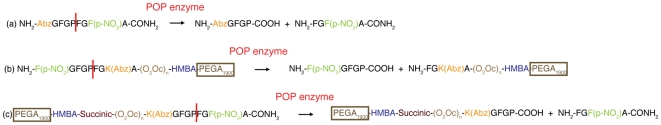
General scheme of the peptides processed by the POP enzyme and the fragments generated.(a) Model substrate (b) C-terminal-anchored peptides (c) N-terminal-anchored peptides.